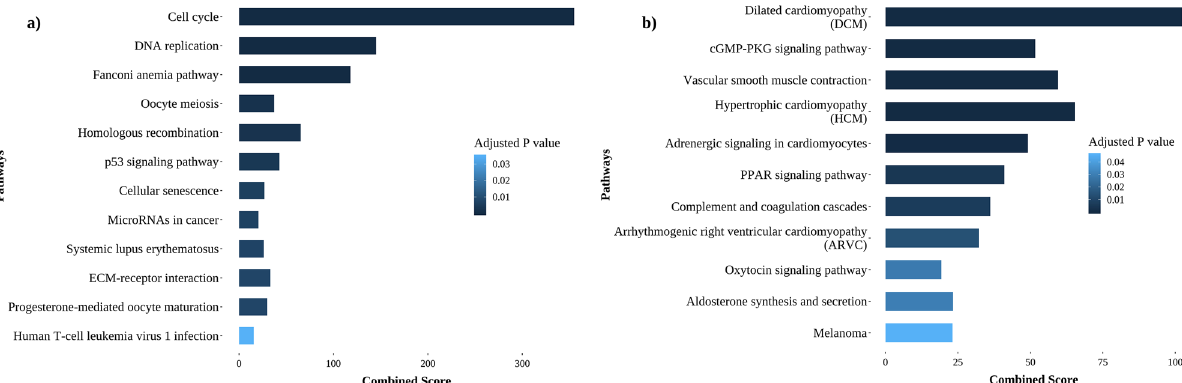
Figure 2. Bar plots representing the enriched pathways of the top 5% high centrality nodes (Adjusted P-value versus Combined score). Combined score represents the product of logarithmic P-value computed using Fisher exact test and z-score. These scores for each pathway are obtained from Enrichr (gene enrichment analysis web- based tool). ( a ) Upregulated, ( b )